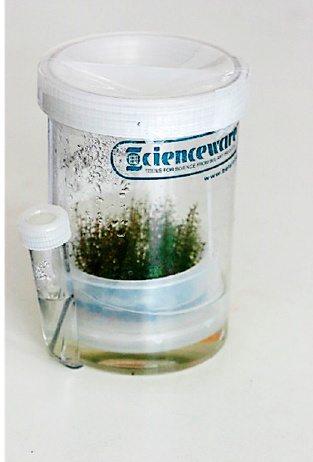
Figure 6. In vitro culture of lingonberry in a Growtek vessel.